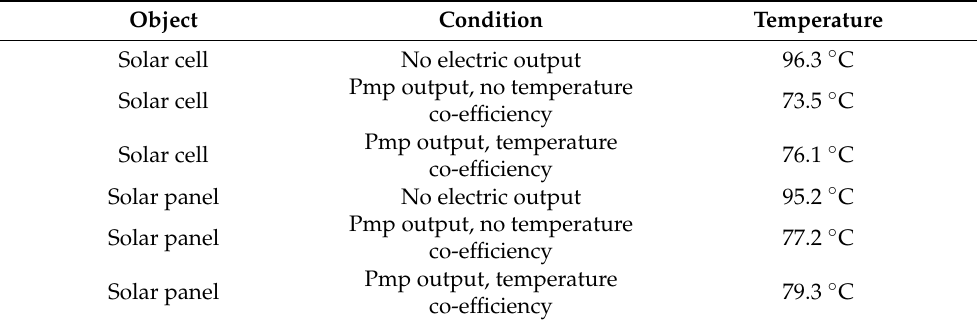
Table 3. Temperature calculation results for the TJ GaAs solar